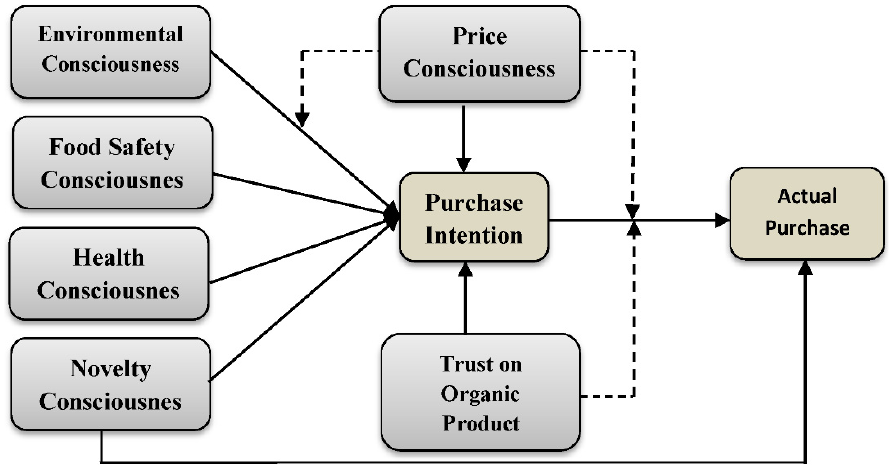
Figure 1. Conceptual Framework.